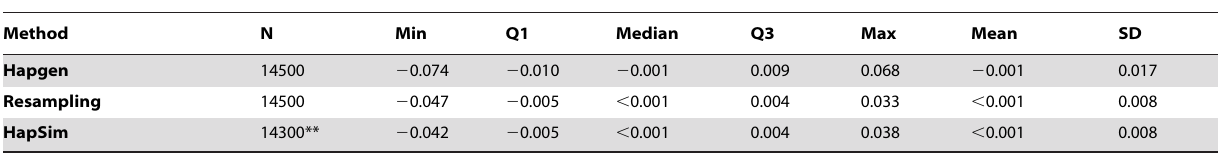
Table 1. MAF–Gene Region 1*.